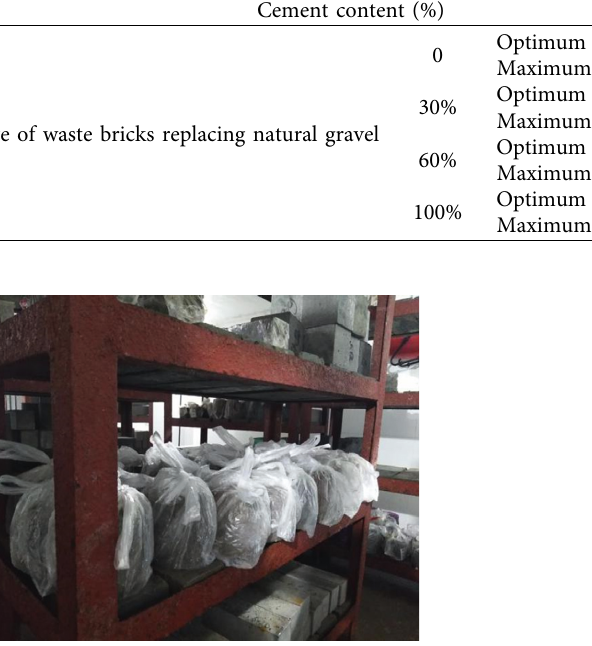
Figure 8: Standard maintenance.